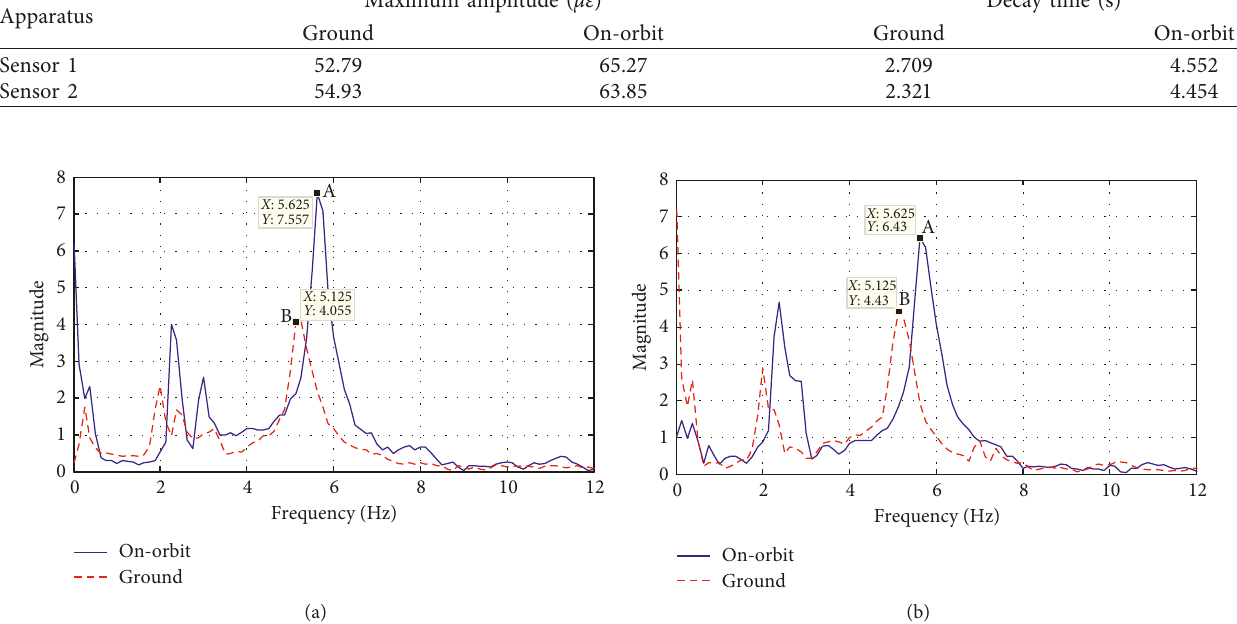
Figure 10: Comparisons of the vibrating strain signals in the frequency domain. (a) Sensor 1. (b) Sensor 2.